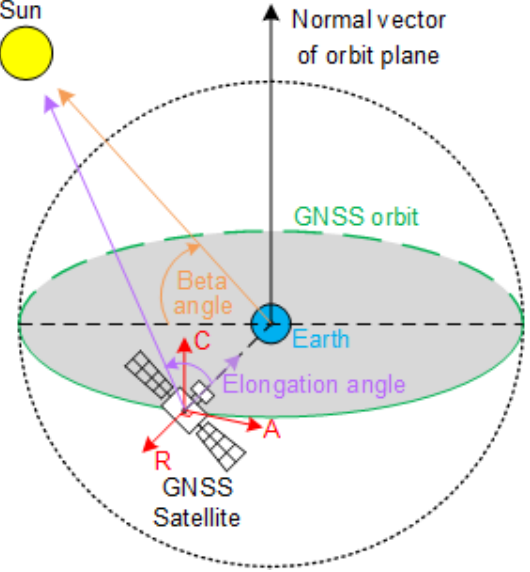
Figure 1. Space geometric angle and position among the sun, Earth, and GNSS satellite.